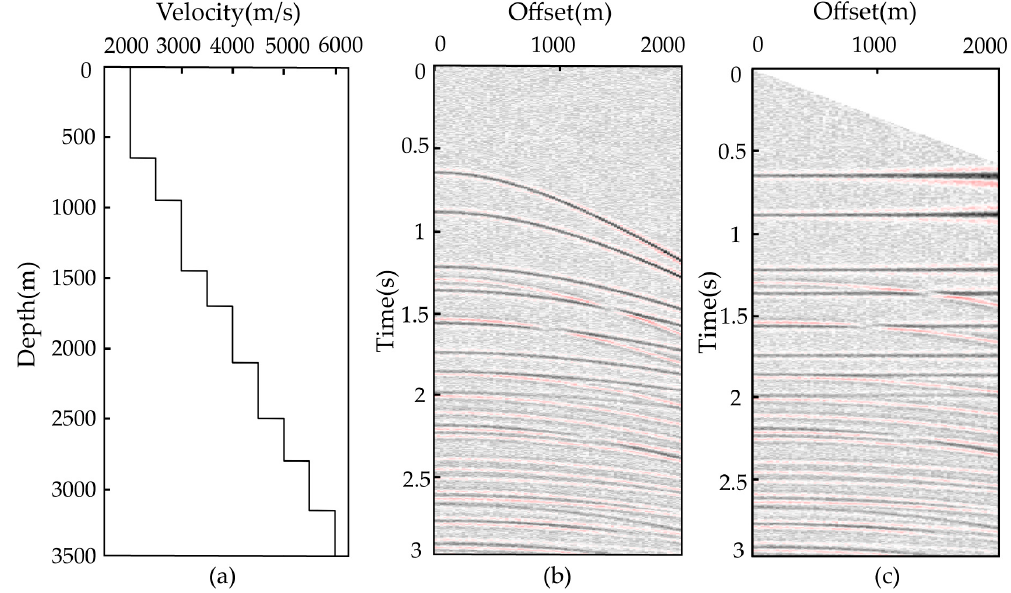
Figure 3. ( a ) Velocity model; ( b ) CMP gather; ( c ) CMP gather after